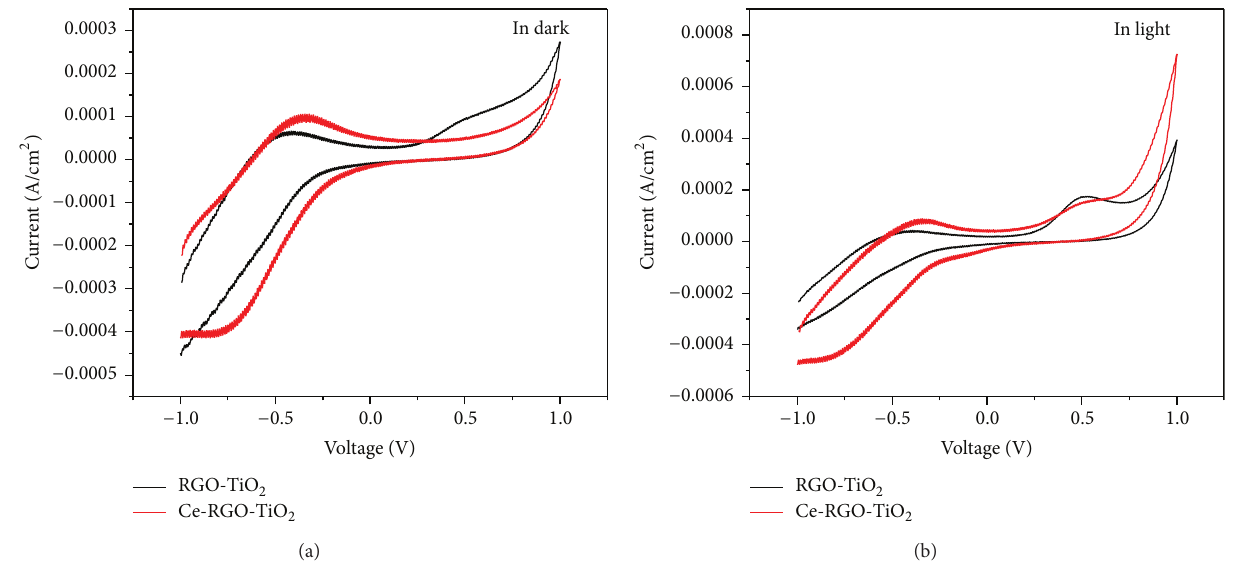
Figure 8: Cyclic voltammogram of catalytic activity with RGO-TiO 2 /ITO and Ce-RGO-TiO 2 /ITO modified electrodes in both dark and visible light irradiation.